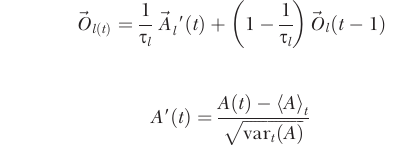
Figure S1. Spatial Distribution of Reconstruction